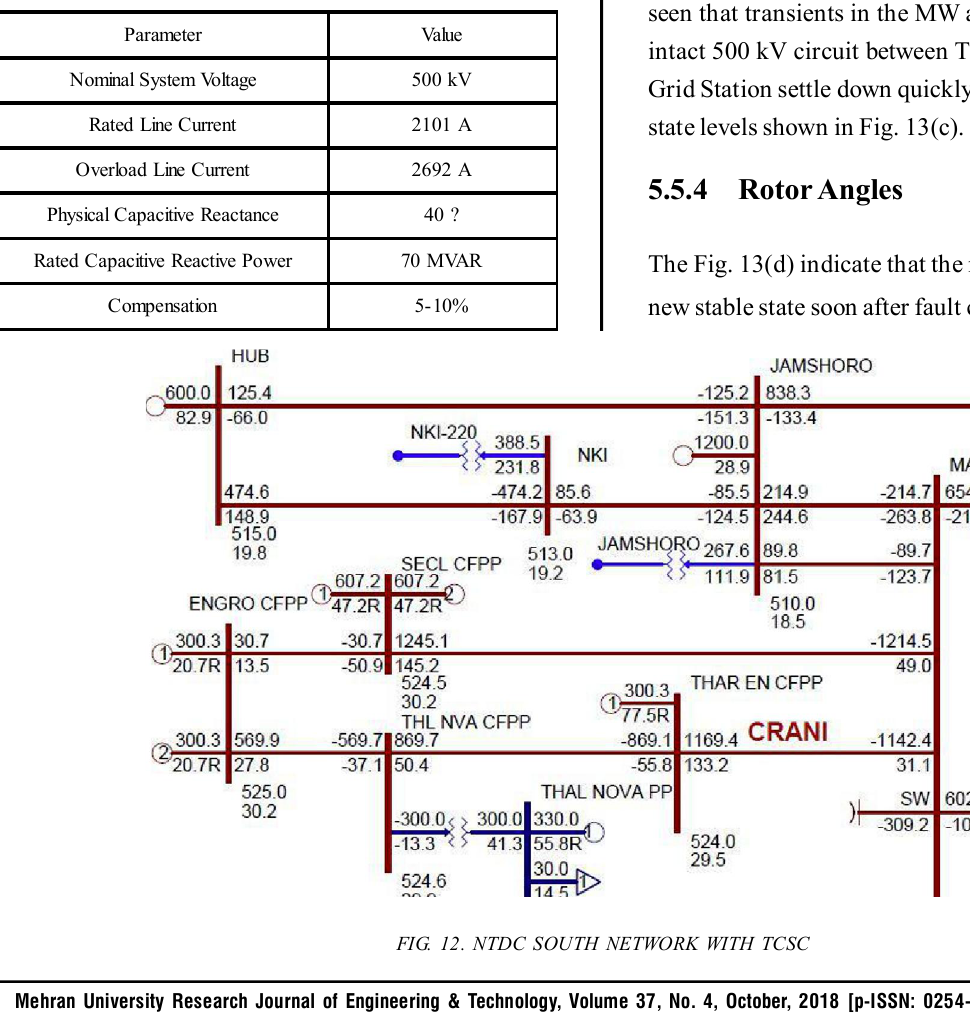
TABLE 2. TCSC TECHNICAL DATA IN TEST SYSTEM